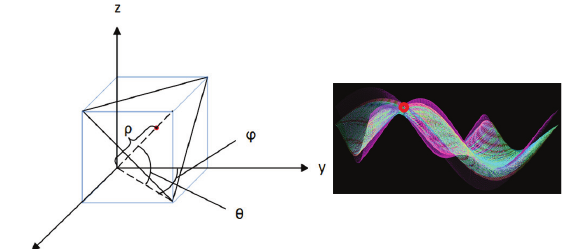
Figure 2. Definition of the Cartesian- and polar-coordinates for the transform (left) and a 3D view of Hough space (right). 3 manifolds intersect at one point (red circle) in Hough space indicates 3 points defining one plane in Euclidean